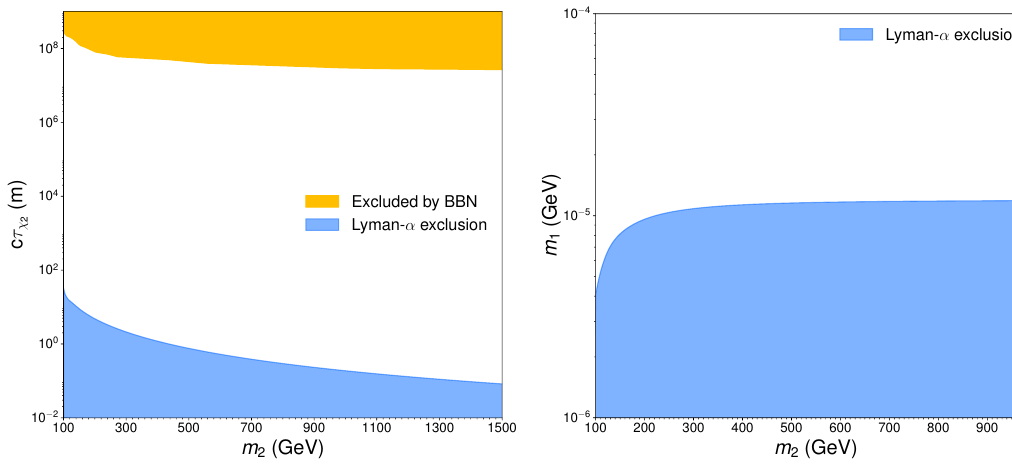
Figure 5 . Left: region in the ( m 2 ; c(cid:28) ) plane excluded from Big Bang Nucleosynthesis (yellow) (cid:31) 2 and from Lyman- (cid:11) forest observations (blue). Right: Lyman- (cid:11) bound on m 1 (blue) from eq. (4.3) as a function of m 2